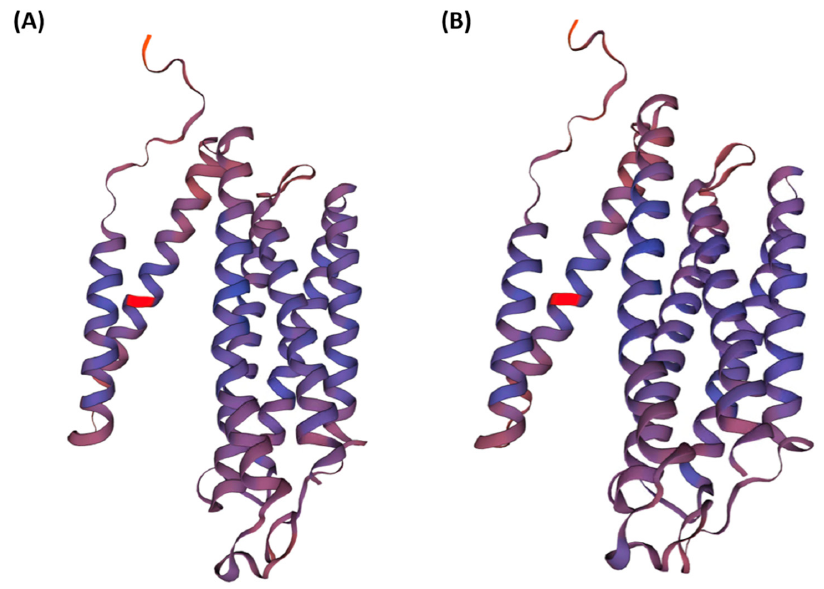
Figure 4. Three-dimensional structure of COX3 with a non-synonymous mutation from heteroplasmy. A three-dimensional structure of COX3 as ribbon type was displayed. The red color indicates amino acid variation identified from the heteroplasmy phenomenon of WBPH mitogenomes. ( A ) The normal type of COX3; ( B ) Mutation type of COX3 is caused by the heteroplasmy phenomenon identified in this study.